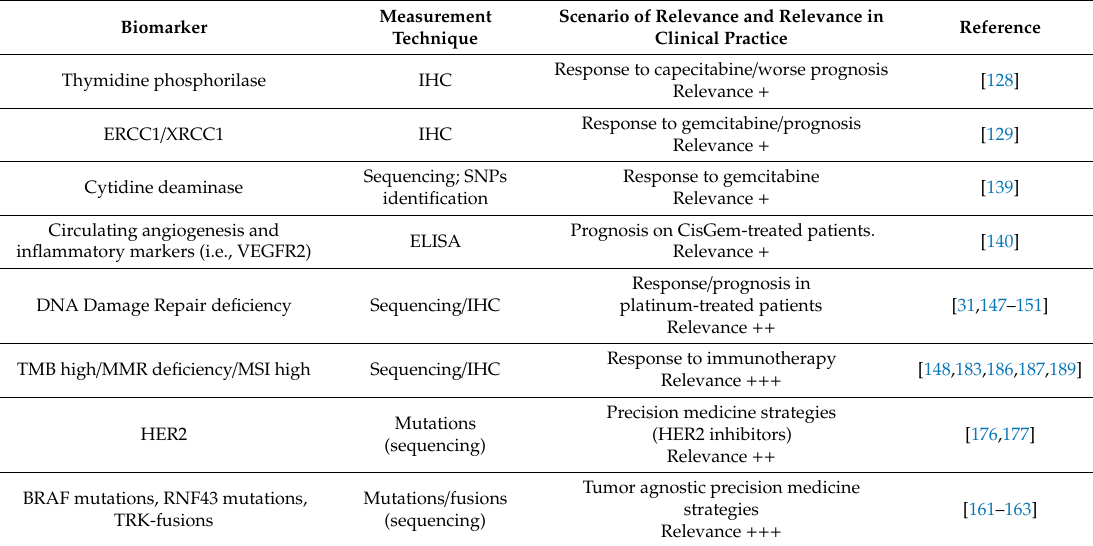
Table 4. Candidate predictive biomarkers for treatment selection in gallbladder